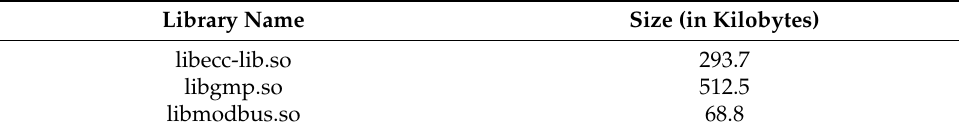
Table 3. Sizes of compiled libraries.